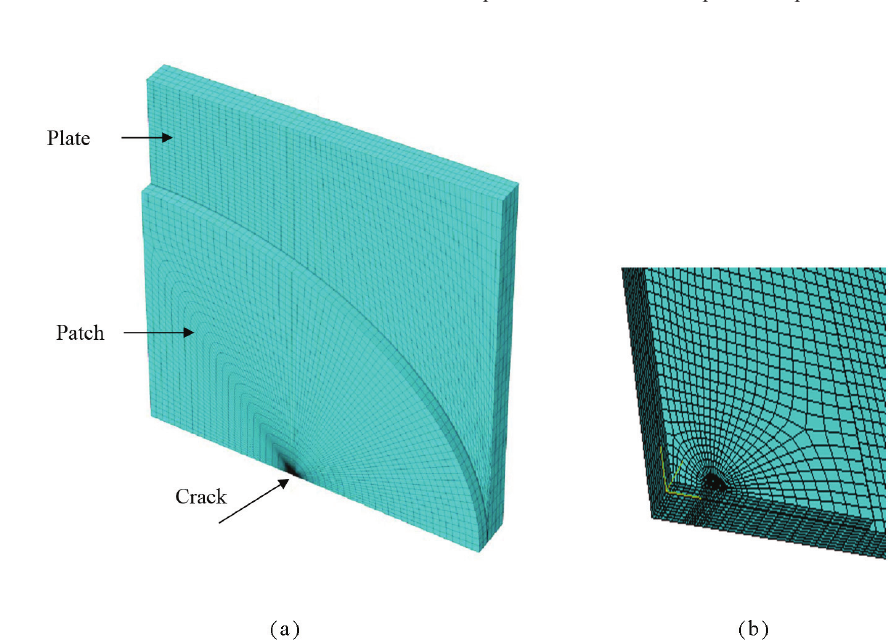
Figure 2. Typical mesh model. a) Of the half of the structures. b) Near the crack